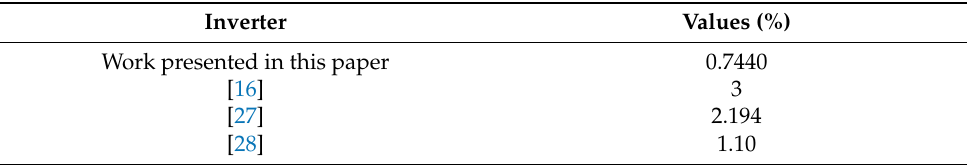
Table 2. The THD comparison between the works in the literature and the work presented in this